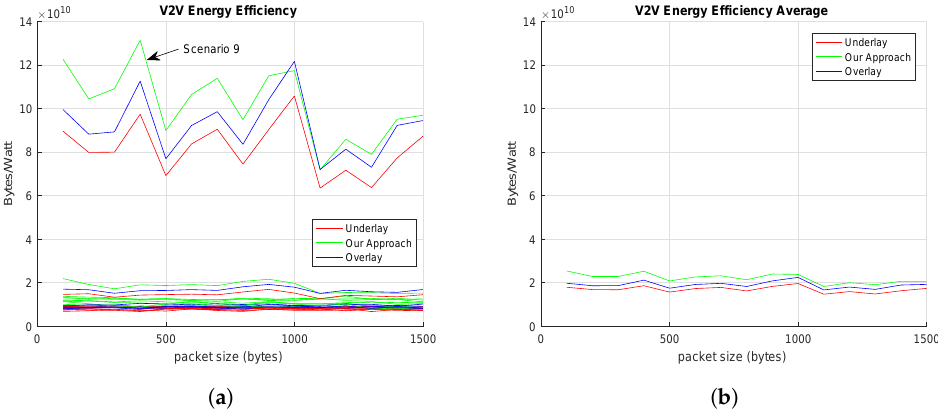
Figure 8. Energy Efficiency offered to V-UEs based on C-UEs’ traffic pattern. ( a ) Total Average Energy Efficiency for V-UEs in different scenarios; ( b ) Total Average Energy Efficiency for